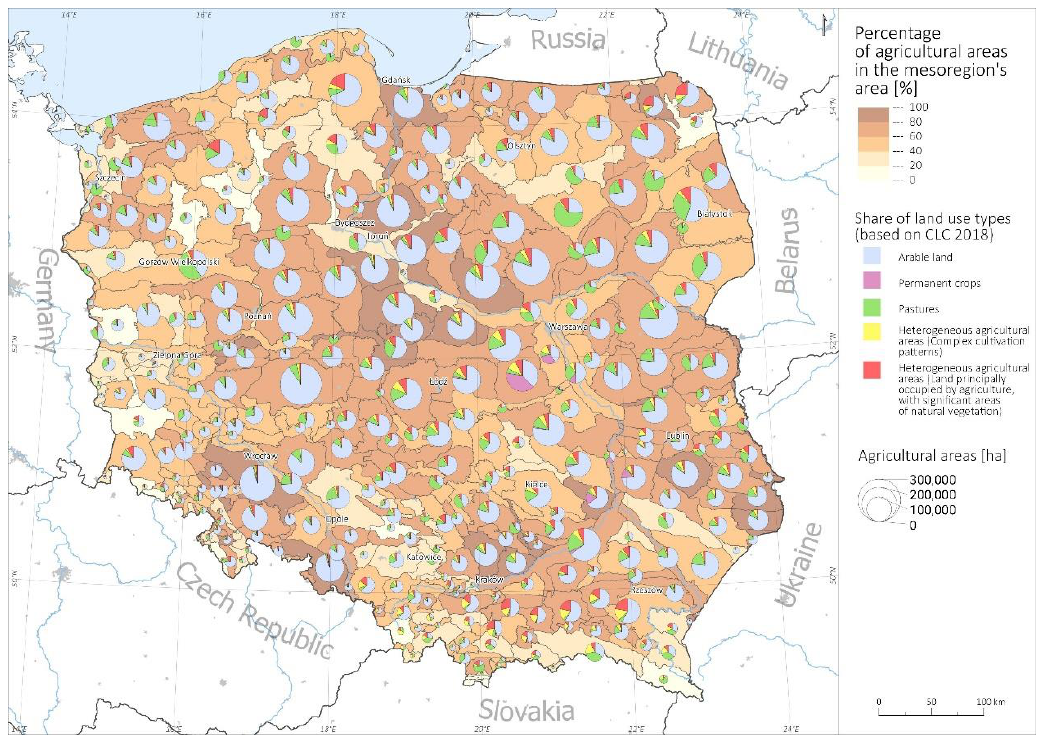
Figure 14. Percentage share of agricultural lands and their breakdown by mesoregions (Source: Authors based on CORINE Land Cover 2018).